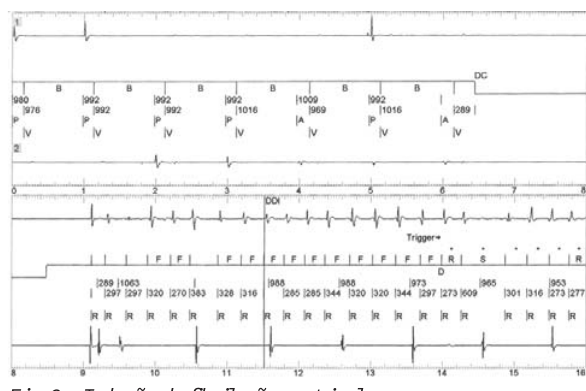
Fig. 2 – Indução da fibrilação ventricular